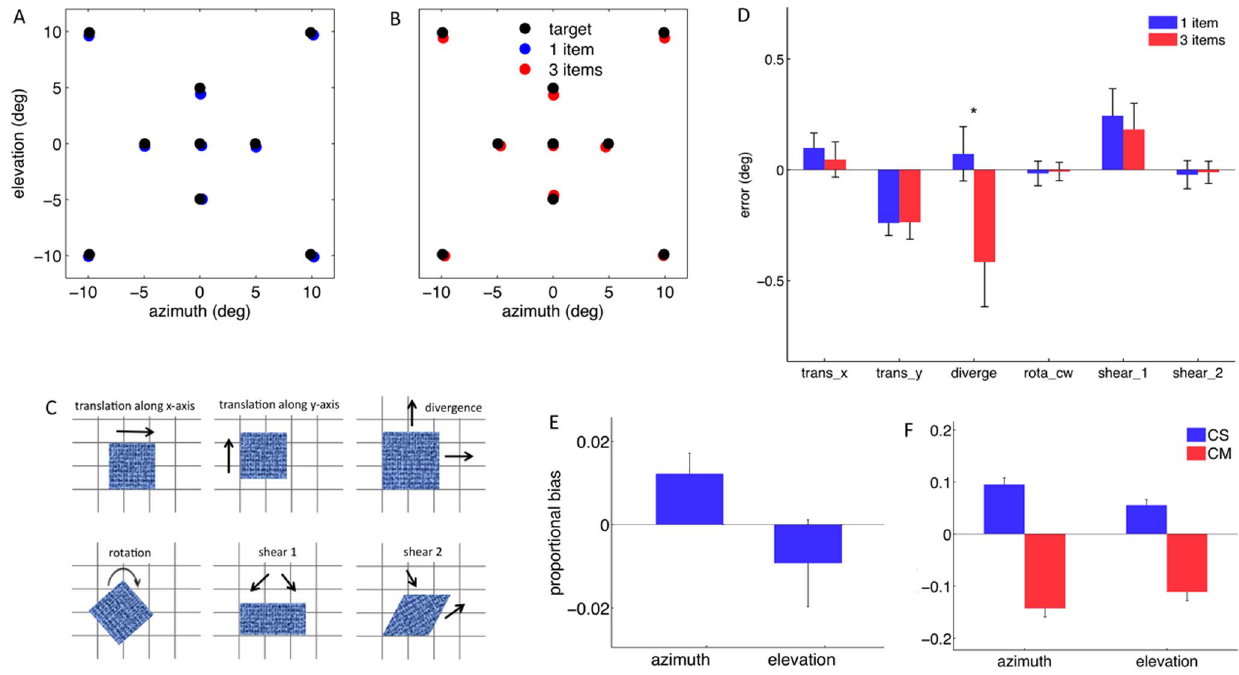
Figure 2. Memory load affects systematic recall error. (A) Recalled targets were systematically displaced outward and downward (in blue) relative to their location in the sample display (in black) when the memory load was one. (B) Recalled targets were displaced toward the center of the display when the memory load was three (in red). (C) The six spatial components of the systematic error are shown, including constant offsets (translation) along azimuth and elevation, and four linear tensors. (D) Memory load only affected the divergence of the error field. For the sake of convenience, the error size is expressed in degrees for the tensors as well. These values correspond to the displacement associated with each component, averaged over all target locations. (E) Proportional recall bias in center of screen (CS) coordinates (in blue) when the memory load is one. (F) Proportional recall bias in CS (in blue) and center of the memory items’ configuration (CM) coordinates (in red) when the memory load is three. Target azimuth, in CS coordinates, was overestimated both when the memory load was one and three. In addition, when the memory load was three, participants underestimated both target azimuth and elevation in CM coordinates. trans - translation, diverge - divergence, rota_cw - clockwise rotation. *p ,